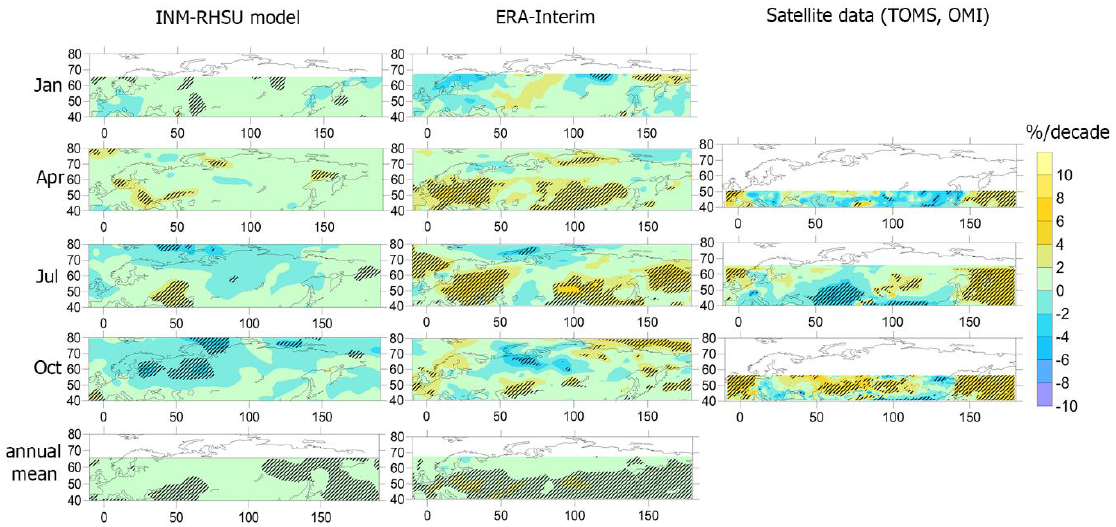
Figure 13. Spatial distribution of the decadal trend in Eery caused by the combined effect of total ozone and cloudiness calculated from the INM-RSHU CCM, ERA-Interim, and TOMS/OMI satellite datasets. Statistically significant differences at 95% are shown by hatching. Note, that we do not present UV retrievals from the TOMS/OMI dataset for January and for annual mean due to the problems in UV retrievals in conditions with high surface snow/ice albedo. X-axis—is longitude, Y- axis—is latitude.